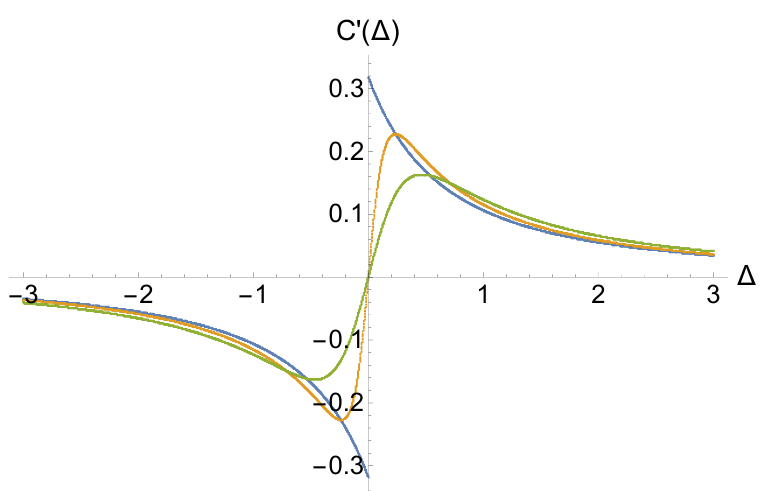
Figure 3 . The derivative of spread complexity with respect to ∆ in the continuum limit for the circuit connecting the free fermion ground state and Kitaev chain ground state. We have set J = 1 . The blue line has µ = 0 . 98 , the orange µ = 1 . 02 and the green µ = 1 . 1 . When crossing the topological phase transition points at | µ | = 1 the derivative develops a